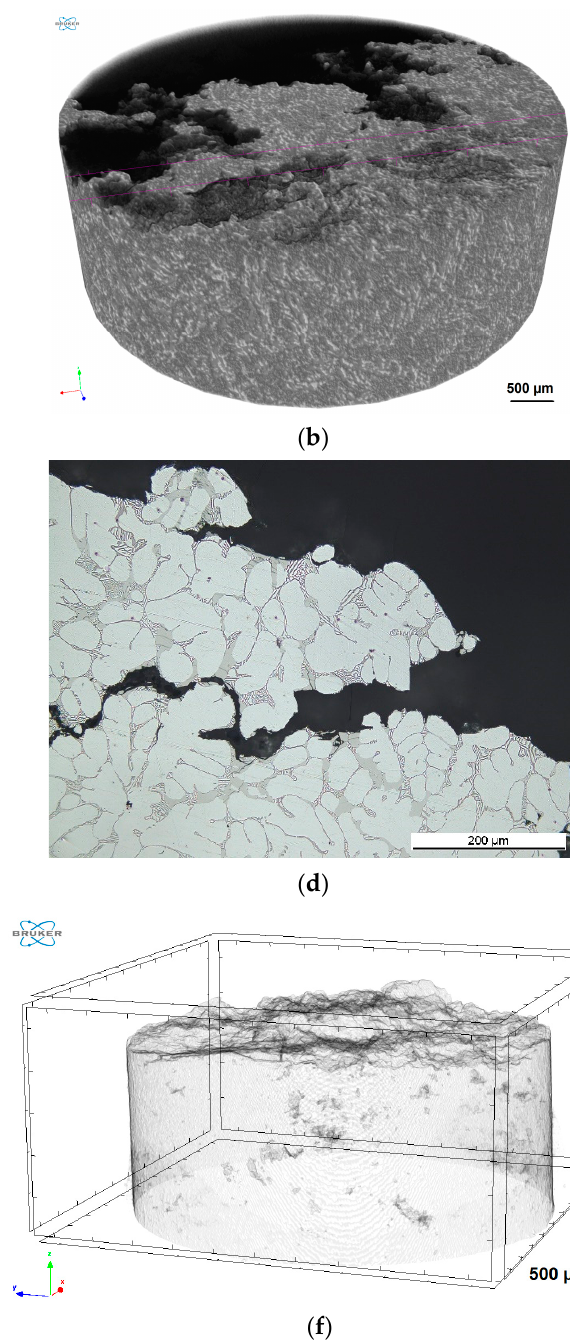
( d ) ( e ) Figure 8. Cross-sectional micrographs of fracture surface after fatigue load (R = − 1, 12,000 cycles) showing the crack propagation of the sub-cracks near the main crack and its interaction with the microstructural features ( a – e ). The gauge length of a sample before loading reveals several large shrinkage cavities by µ-CT analysis (Figure 9a,b)—two of them are located near the middle of the gauge length, where the diameter is the smallest. It is of interest whether these cavities locate the failure position. The SEM image and the reconstructed pores by the µ-CT analysis in Fig- ure 9c–e highlight the large shrinkage cavities in the fracture surface after the sample failed by tensile loading. During fatigue testing, the monitoring of the hysteresis loops